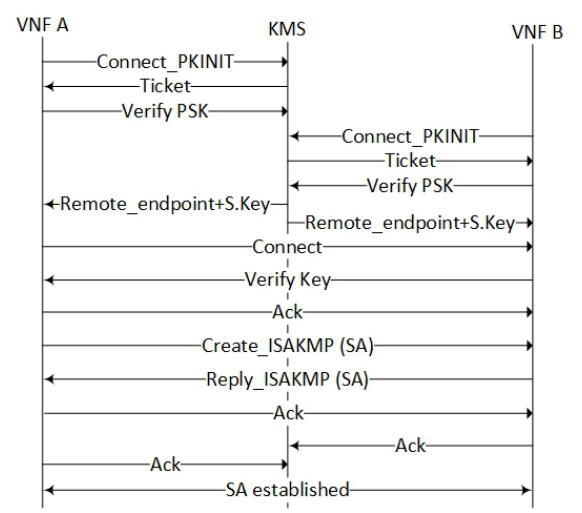
Figure 19. The KMS protocol